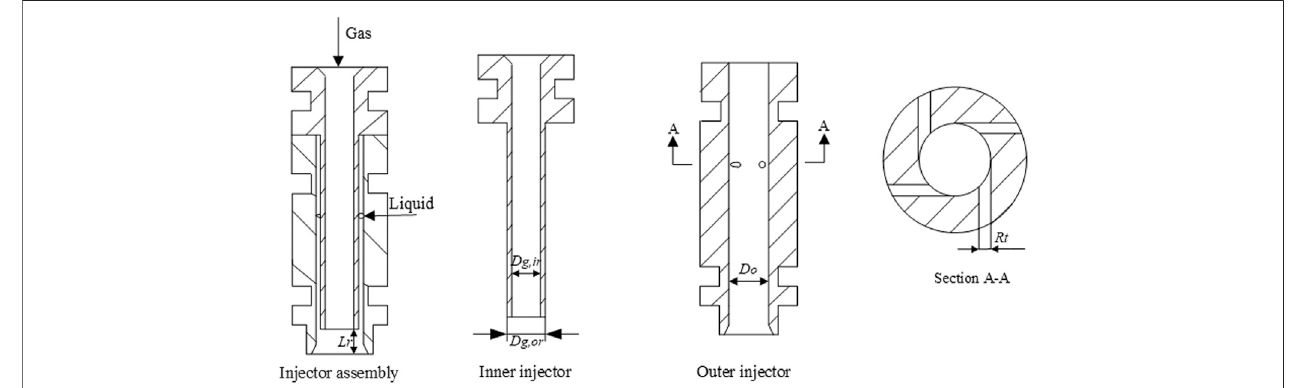
FIGURE 1 | Geometry of the injector.